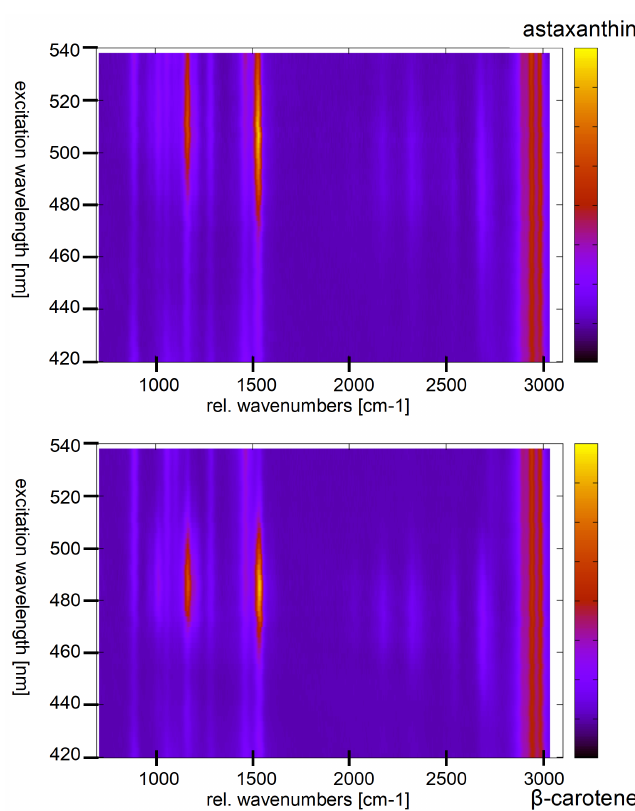
Figure 14. Resonance maps of astaxanthin ( top ) and β -carotene ( bottom ) solved in ethanol. The triple-band around 2900 cm − 1 showing constant intensity over the whole excitation range originates from ethanol as do all constant lines in the fingerprint region. All lines with varying intensity originate from the carotenoids. Above 2000 cm − 1 variable Raman lines are overtones and combination bands (reproduced with permission from